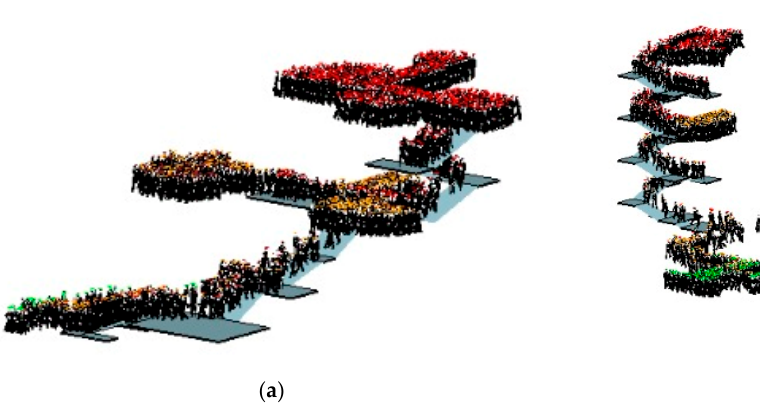
Figure 10. Crowding on the stairs at 200 s from the start of the evacuation: ( a ) Wooden and October Staircase; ( b ) Saltykov (left), and Great Church Staircase (right).